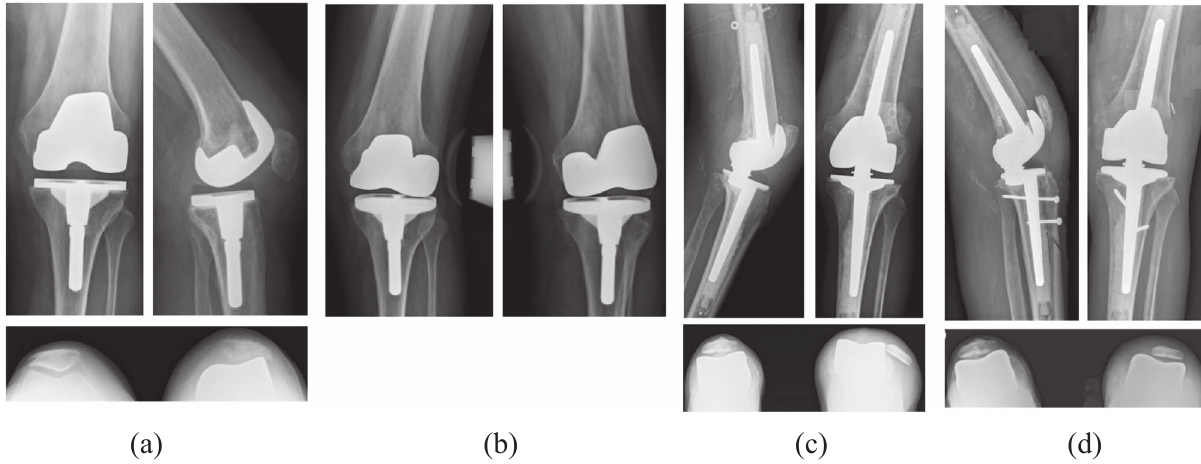
Figure 3. A 74-years-old woman with femorotibial instability of a primary TKA with two prior prosthesis dislocations (A) and (B). A revision TKA with an RHK prosthesis (Rotax – Groupe Lépine (cid:4) ) was performed. A recurrent patellar dislocation appears at two months postoperatively (C), requiring further surgery to stabilize the patella: medialization of the anterior tibial tuberosity via osteotomy and medial patello-femoral ligament reconstruction with quadriceps tendon autograft and endo-button fi xation through a femoral tunnel